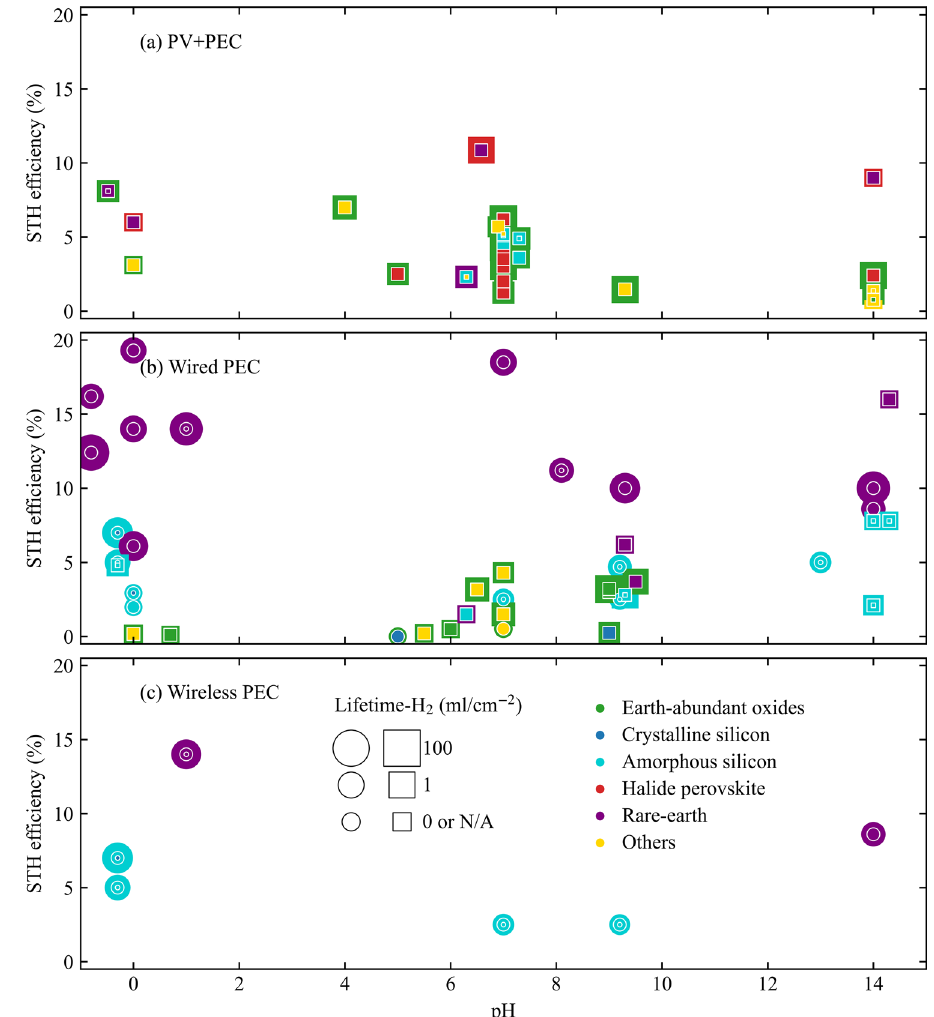
Fig. 5 STH efficiency from the previous studies [7, 8, 11, 21, 26–74] depending on the pH of the electrolyte and the device structures: a PV + PEC, b Wired PEC and c Wireless PEC. The shape of the data points represents the inclusion of SSJ-T in a device structure (circle: not included, rectangle: included). The colors of outer, middle (for devices with three light absorbers) and inner circle or rectangle corresponds to top, middle (for devices three light absorbers) and bottom cell materials, respectively. Differ- ent colors represent different light absorbers (green: earth- abundant oxide, blue: crystal- line Si, light blue: amorphous Si, red: halide perovskite, purple: any materials contain- ing In, As or Ge, yellow: others, which are mostly chalco- genides and organics). The size of datapoint represents lifetime-H in log 2